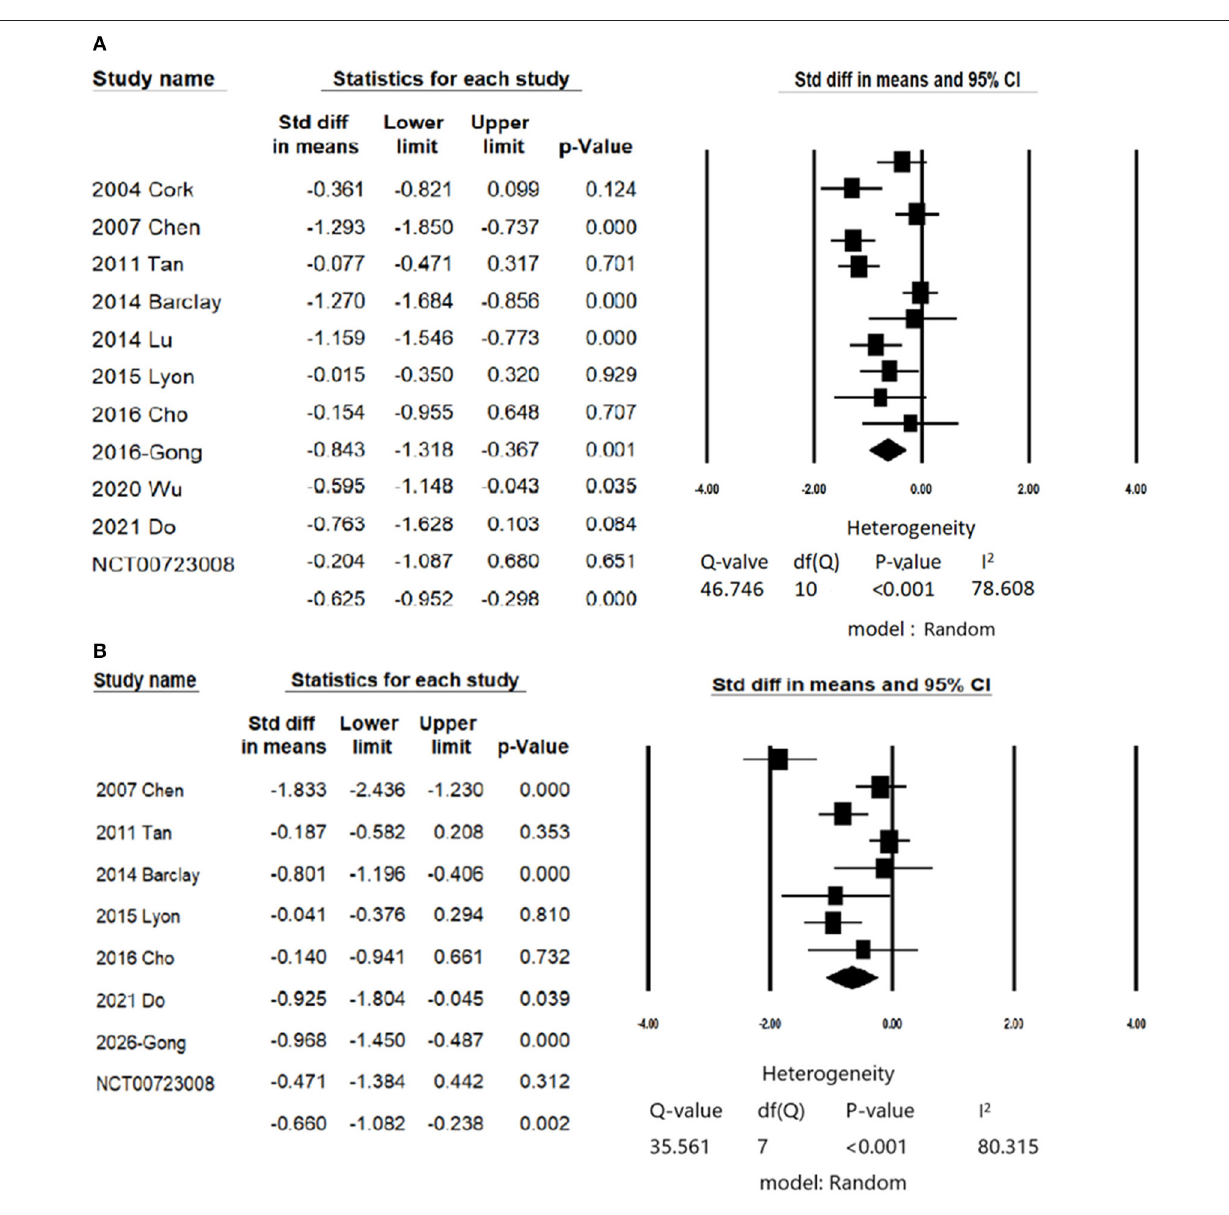
FIGURE 2 | Forest plot of meta-analysis of (A) Primary outcome: change in scores of anxiety symptoms; (B) Secondary outcome: change in scores of depression